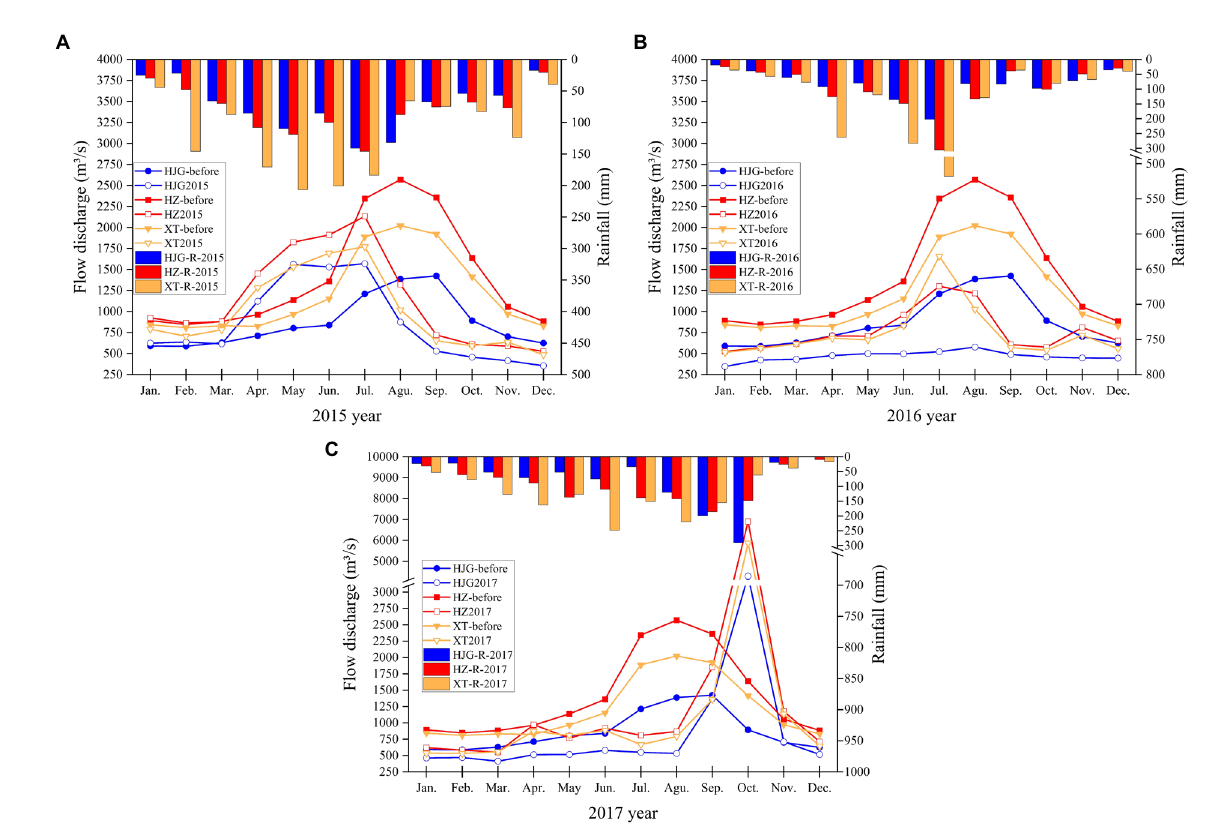
FIGURE 7 Comparison of hydrometeorological conditions before and after the operation of the MRSNWDPC: (A) the year 2015, (B) the year 2016, (C) the year 2017 (Note: “HJG” station locates in the sampling site “SW”, “HZ” station locates in the sampling site “HZ”, and “XT” station locates in the sampling site “SL”,